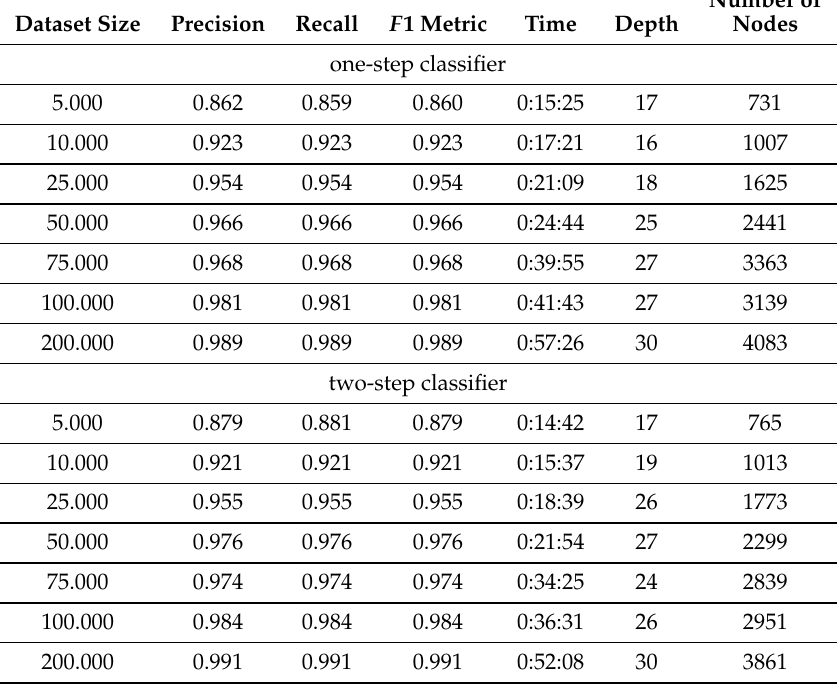
Table 11. Decision